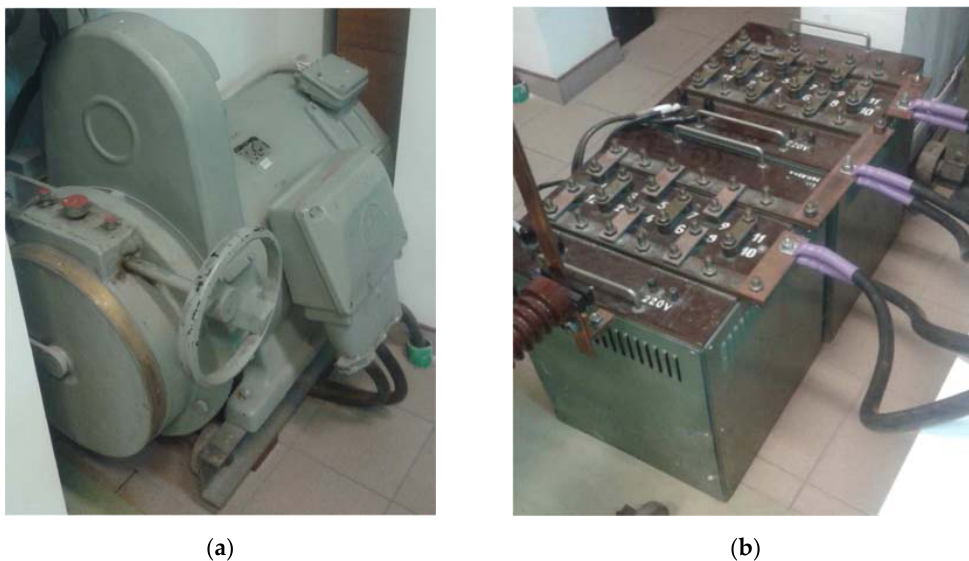
Figure 14. Power supply system used for tests: ( a ) three-phase regulated mains current source; ( b ) three-phase adjustable power transformer.